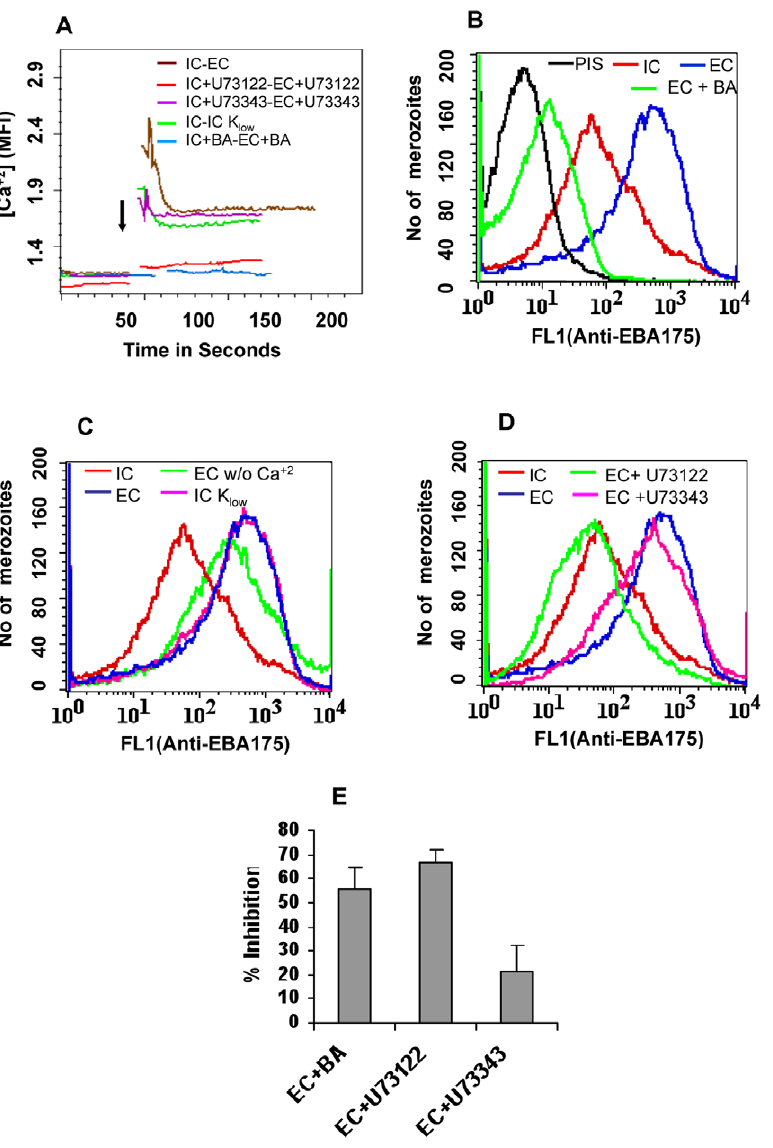
Figure 4. Cytosolic calcium levels and expression of EBA175 on merozoite surface in response to changes in ionic conditions. ( A ) Cytosolic calcium levels in merozoites under different ionic conditions . P. falciparum merozoites were isolated in buffer mimicking intracellular conditions (IC – 5 mM NaCl, 140 mM KCl, 1 mM EGTA). Merozoites were labeled with Fluo-4AM and cytosolic calcium levels [Ca + 2 ] were measured by flow cytometry before and after transfer from IC buffer to buffer mimicking extracellular conditions (EC – 140 mM NaCl, 5 mM KCl, 1 mM CaCl 2 (IC-EC, brown)) or IC K low buffer (IC K low - 5 mM NaCl, 5 mM KCl, 135 mM choline-Cl, 1 mM EGTA (IC-IC K low , green)). Merozoites isolated in IC buffer were transferred to EC buffer after prior treatment with either BAPTA-AM (IC + BA-EC + BA, blue) or U73122 (IC + U73122-EC + U73122, red) or its inactive analog U73343 (IC + U73343-EC + U73343, purple). Mean fluorescence intensities (MFI), which reflect relative levels of free cytosolic calcium measured by flow cytometry, are shown as a function of time in seconds. Arrow indicates time-point at which merozoites were transferred from IC buffer. ( B ) Surface expression of EBA175 under different ionic conditions . Expression of EBA-175 was detected on surface of merozoites isolated in IC buffer (IC, red), following transfer from IC to EC buffer (EC, blue) or following transfer from IC to EC buffer after prior treatment with BAPTA-AM (EC + BA, green) using specific sera by flow cytometry. Merozoites isolated in IC buffer and stained with pre-immune serum (PIS, black) were used as controls. ( C ) Surface expression of EBA175 in response to change in [K + ] . Expression of EBA-175 was detected on surface of merozoites isolated in IC buffer (IC, red), after transfer from IC to EC buffer (EC, blue), IC K low buffer (IC K low , pink) or EC w/o Ca + 2 buffer (140 mM NaCl, 5 mM KCl, 1 mM EGTA (EC w/o Ca + 2 , green) using specific sera by flow cytometry. ( D ) Effect of PLC inhibitor U73122 on surface expression of EBA175 . Expression of EBA175 was detected on surface of merozoites isolated in IC buffer (IC, red), following transfer from IC to EC buffer (EC, blue) or from IC to EC buffer following pre-treatment with either U73122 (EC + U73122, green) or its inactive analog U73343 (EC + U73343, pink) using specific sera by flow cytometry. ( E ) Invasion rates in presence of calcium signaling pathway inhibitors . Merozoites were allowed to invade erythrocytes in presence of calcium chelator BAPTA-AM (EC + BA), PLC inhibitor U73122 (EC + U73122) or its inactive analog U73343 (EC + U73343). Newly invaded rings were scored by Giemsa staining. Invasion rates in RPMI1640 medium in absence of any calcium modulating agents were used as controls to determine invasion inhibition rates in presence of BAPTA- AM, U73122 and U73343.